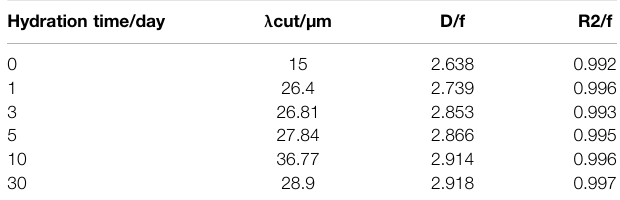
TABLE 2 | The PMs fractal dimensions D and fi tted parameters at different hydration times. Hydration time/day